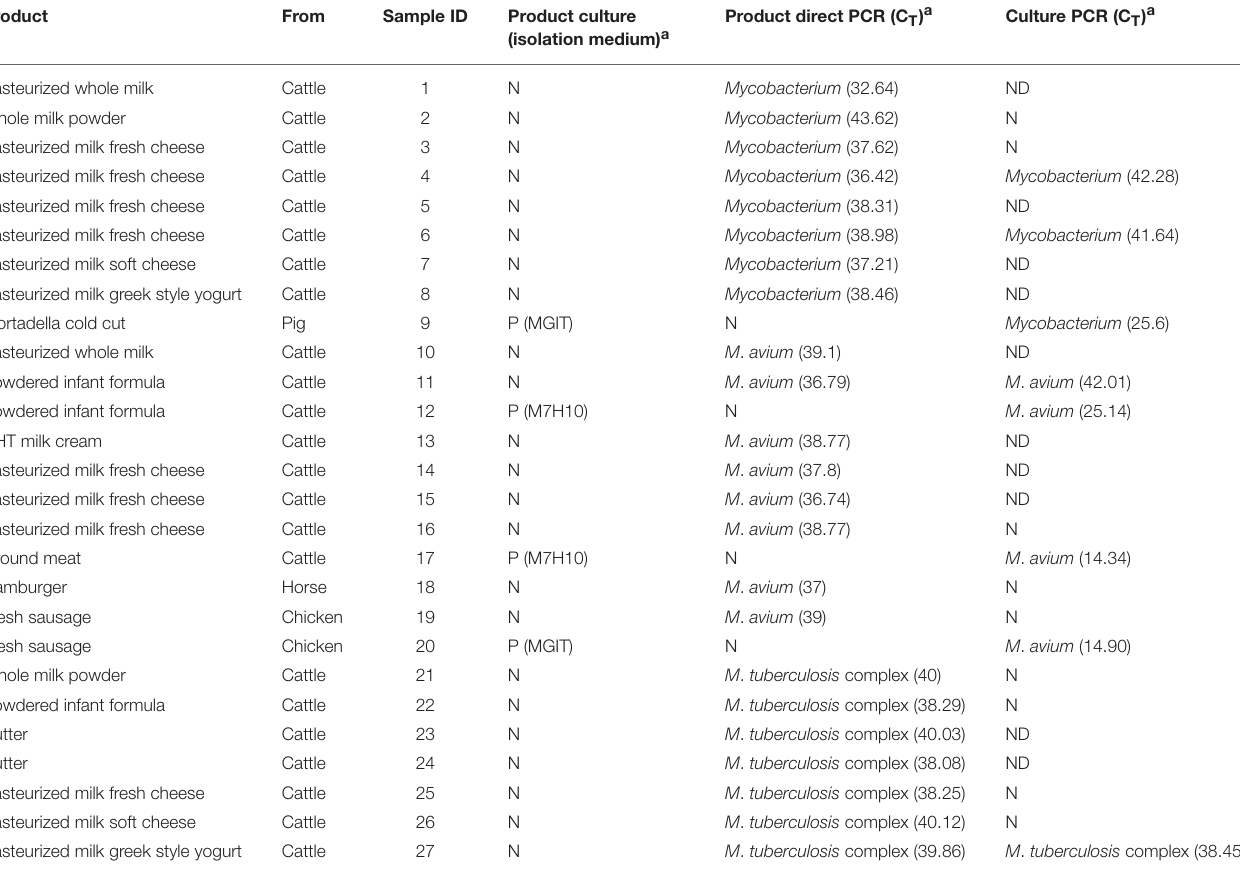
TABLE 2 | Culture and screening tetraplex real-time PCR results of positive samples (detection of M . avium , M . tuberculosis complex and genus Mycobacterium